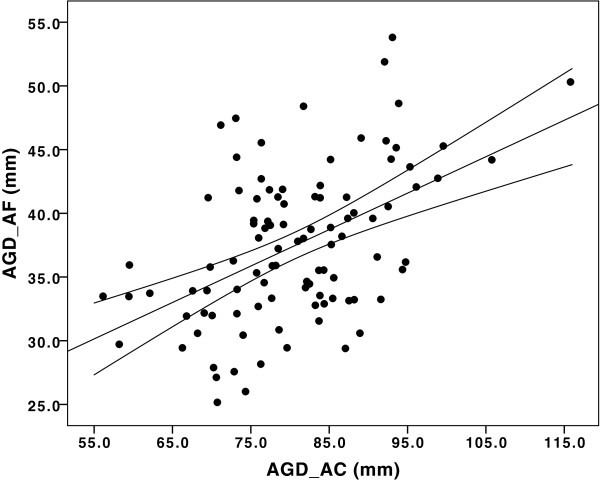
Correlations between AGDAF and AGDAC measures in the MYWS.